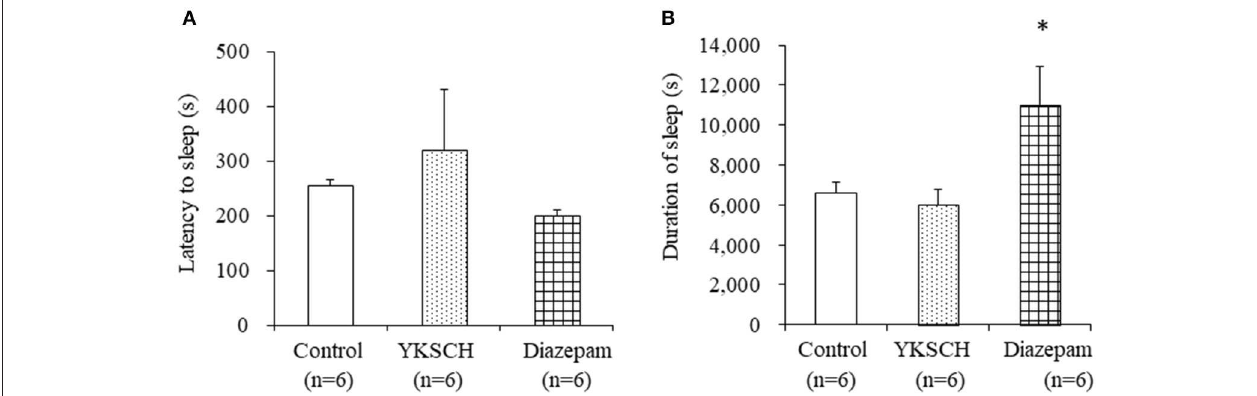
FIGURE 3 | Effect of 3-week treatment with YKSCH on pentobarbital-induced sleeping behavior in group housed mice. One hour after the last injection, mice were treated with pentobarbital. Sleep latency (A) and duration (B) were measured. Diazepam was administered once, 1h before pentobarbital injection. Data are expressed as the mean ± SEM ( n = 6). * p < 0.05 vs. the control group, Peritz’s F -test.